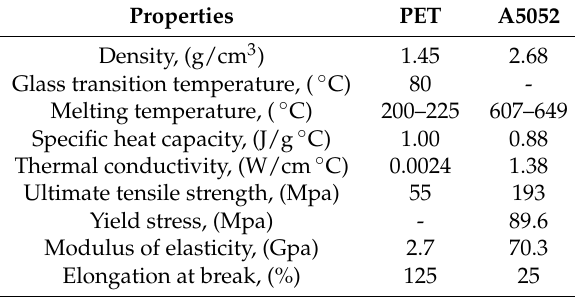
Table 2. Physical and mechanical properties of polyethylene terephthalate (PET) and